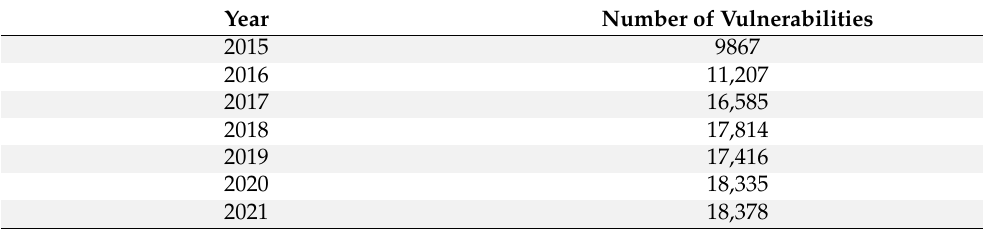
Table 1. NIST graph according to